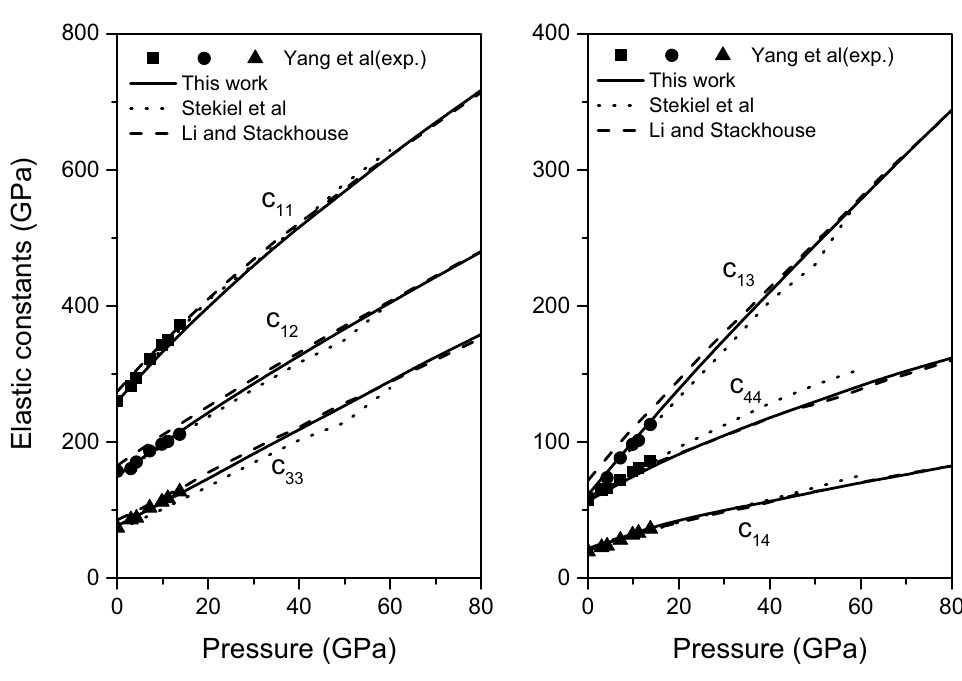
Figure 3. Elastic constants of magnesite from 0 to 80 GPa.